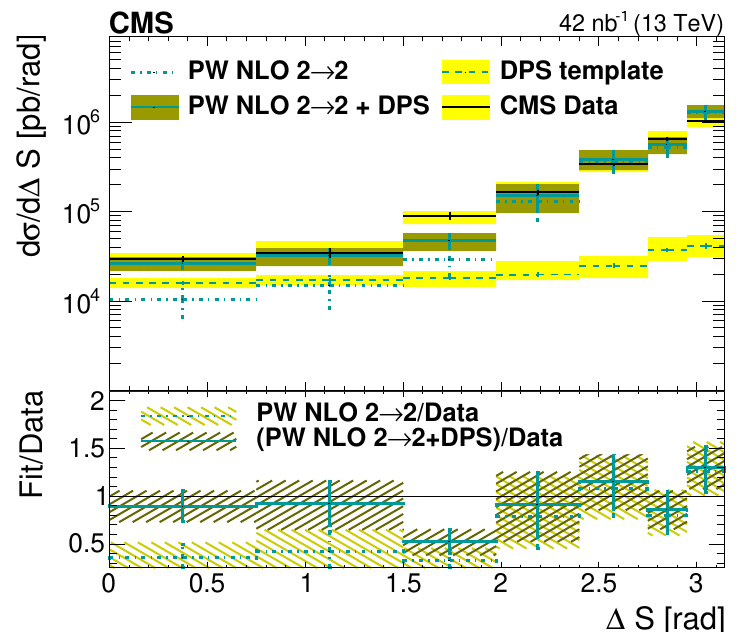
Figure 14 . The results of the template fit for the powheg (PW) NLO 2 → 2 model without the hard MPI removed. The yellow bands represent the total uncertainty of the distribution. The ratio of the scaled MC model and of the total fitted result over the data are shown in the bottom plot. Since the ∆ S distribution obtained from the mixed data sample carries a statistical and systematic uncertainty, so does the total fitted sample. The total uncertainty in the ratio is shown on the